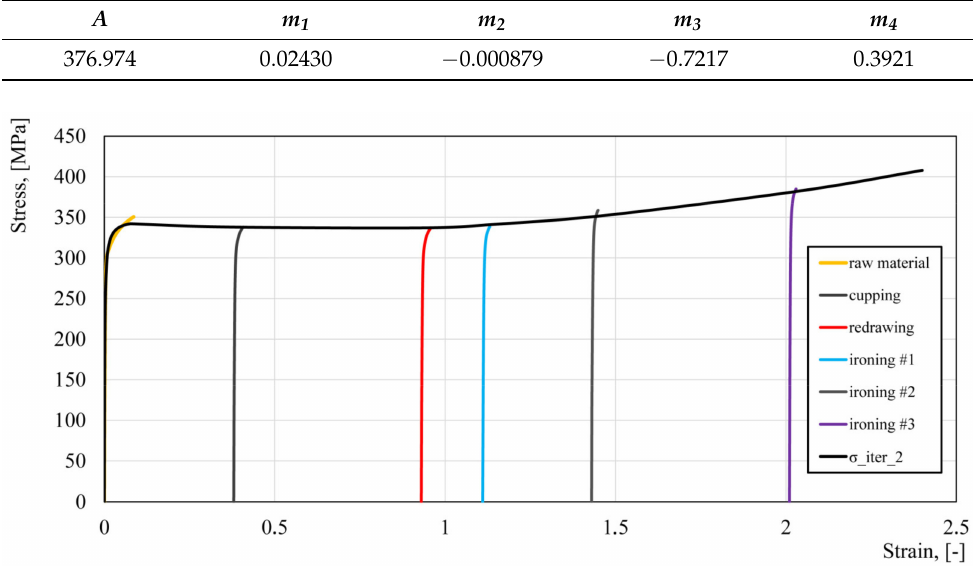
Table 5. Parameters of the (Equation (2)) model for the second iteration of the fitting algorithm.